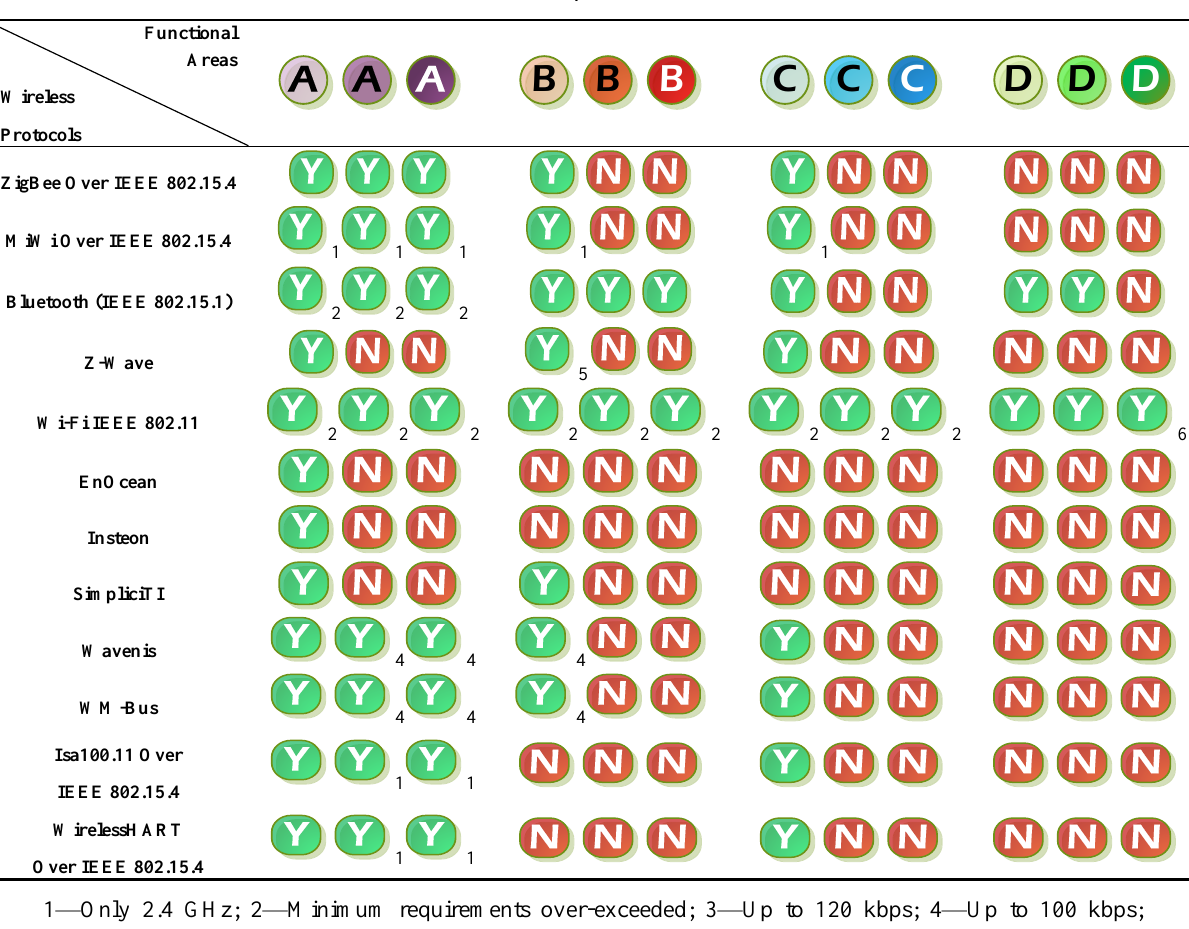
Table 5. Functional Areas Requirements vs . Wireless